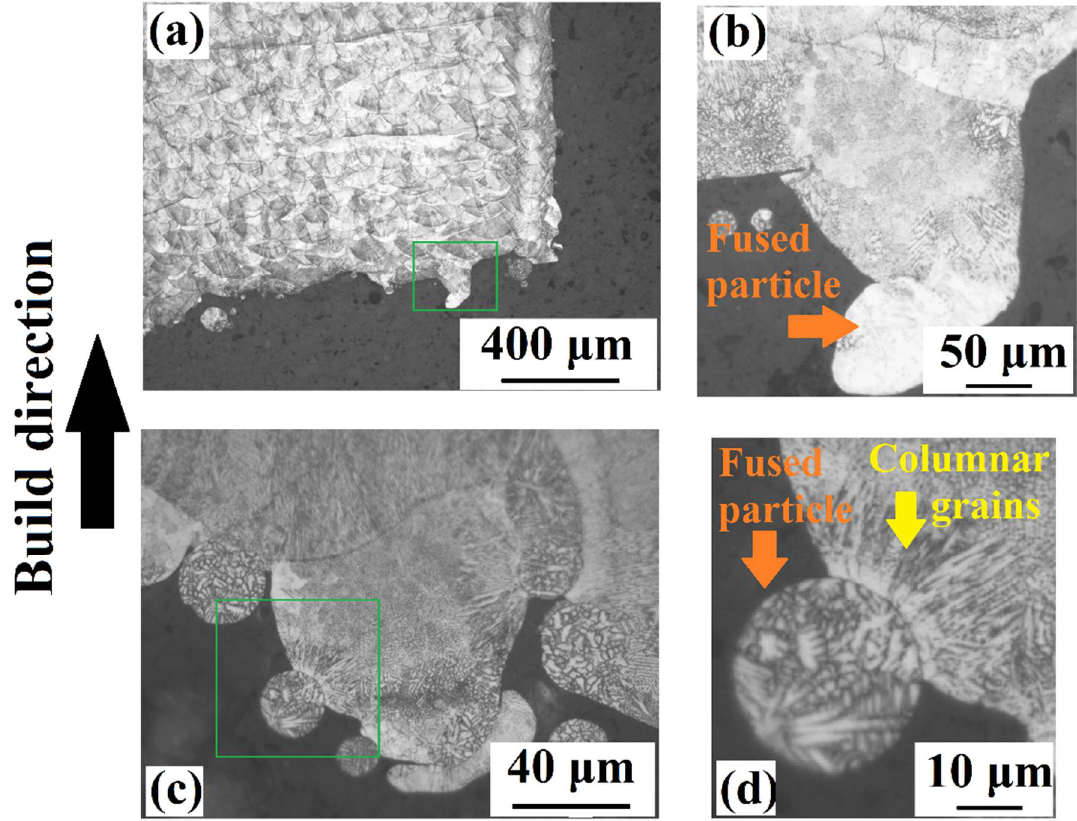
Figure 3. The cross-sectional OM images obtained from: ( a ) US-30° (×50) and ( b ) US-30° (×200), ( c ) US-45° (×1000) and ( d ) US-45° (×2000). ( c ) US-45 ◦ ( × 1000) and ( d ) US-45 ◦ ( ×